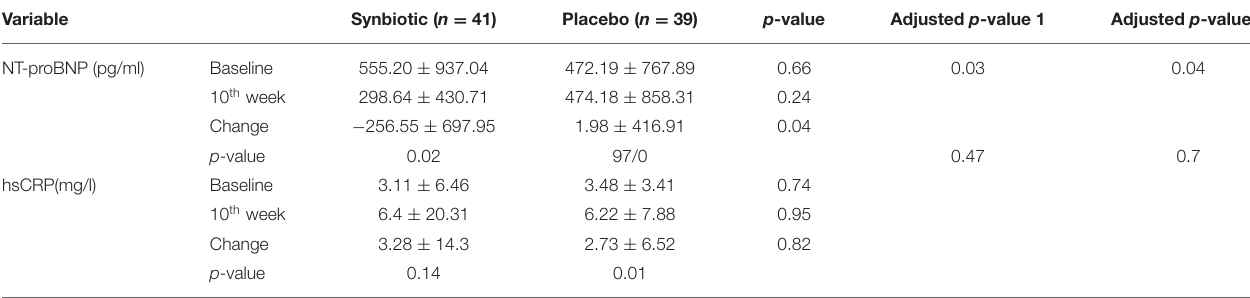
TABLE 3 | Biochemical measurement at baseline, at the end of the study and changes between the synbiotic and placebo groups.